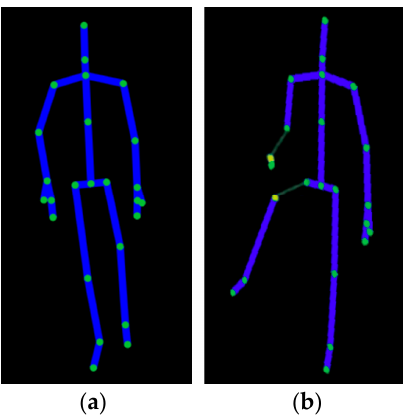
Figure 3. Preview of the user’s skeleton when: ( a ) all joints are properly tracked; ( b ) Kinect is not able to determine the position of certain joints.